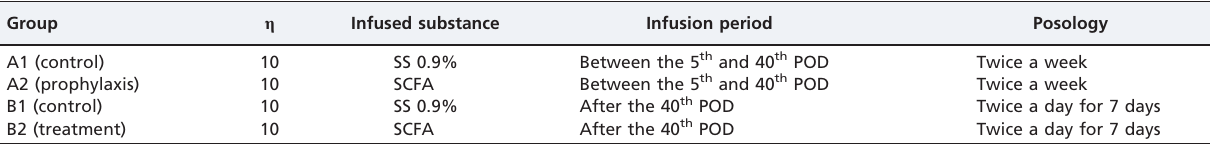
Group g Infused substance Infusion period Posology A1 (control) 10 SS 0.9% Between the 5 th and 40 th POD 10 SCFA Between the 5 th and 40 th POD 10 SS 0.9% After the 40 th POD 10 SCFA After the 40 th